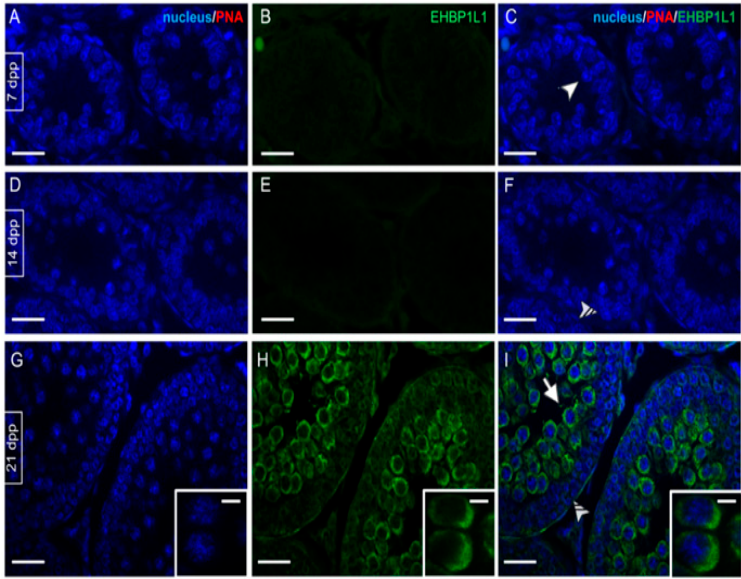
Figure 3. Localization of EHBP1L1 during the first wave of rat spermatogenesis (7–21 dpp). ( A , D , G ) DAPI-fluorescent nuclear staining (blue) and PNA lectin acrosome staining (red). ( B , E , H ) EHBP1L1 fluorescence (green). ( C , F , I ) Merged fluorescent channels (blue/red/green). ( A – C ) 7 dpp testis; ( D – F ) 14 dpp; ( G – I ) 21 dpp. Scale bars represent 20 µ m, except for the insets, where they represent 10 µ m. Arrowhead: gonocytes; striped arrowhead: SPG; arrow: I